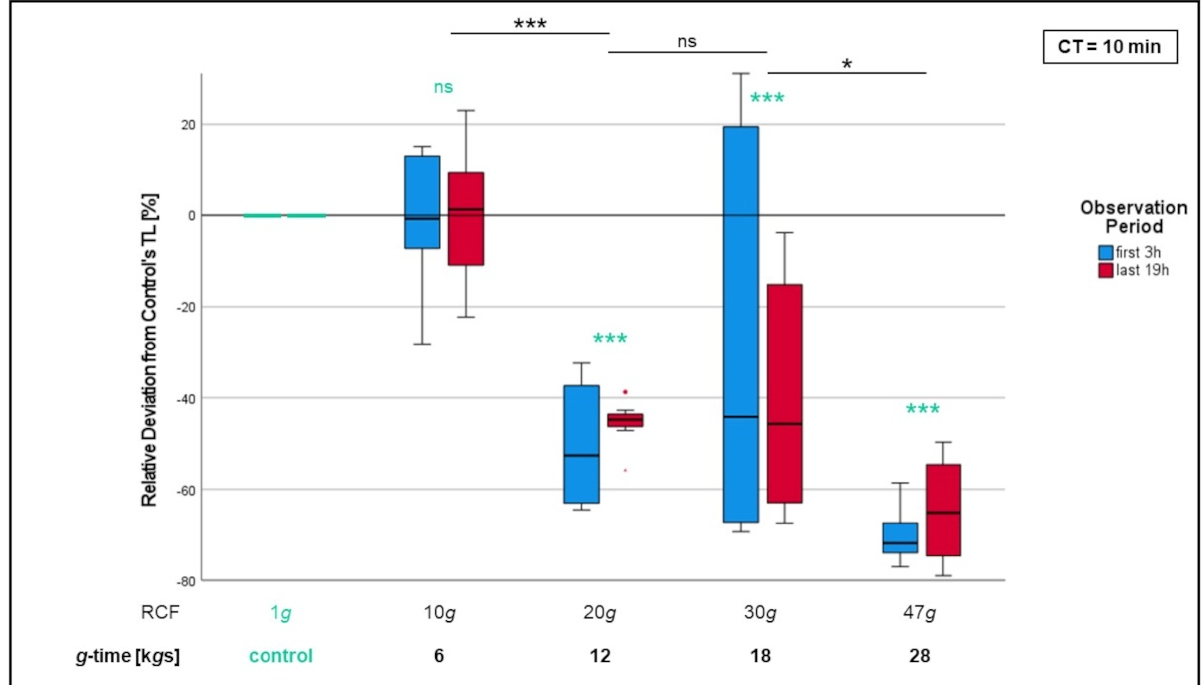
Figure 5 . Comparison of chemotactic migration of PMNs after isolation with different RCFs but an equal CT of 10 min. Mean track length of 1 g control cells was set as default value (“0”; turquoise colored). Mean track lengths of non-control cells are expressed as “relative deviation from control’s track length (TL)”. Significant differences compared to the 1 g control are turquoise colored. Significant differences between non-control samples are indicated with bars. Differences between analyzed groups in graphics are marked as: ns = not significant; * p < 0.05; *** p < 0.001.